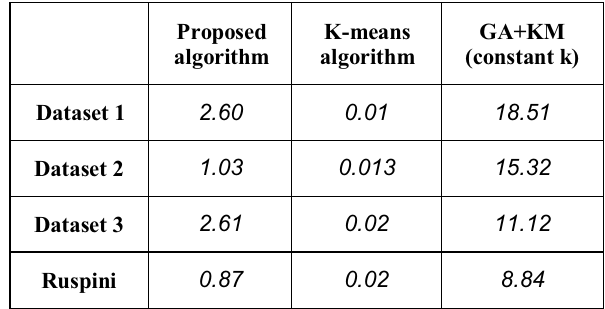
Table 3. Performance